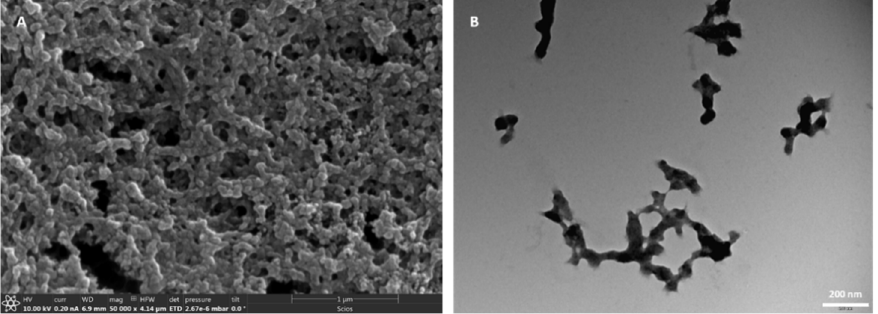
Figure 2. ( A ) Field emission scanning electron microscopy (50,000×) and ( B ) Transmission electron microscopy (46,000×) image of RA-SFNs.